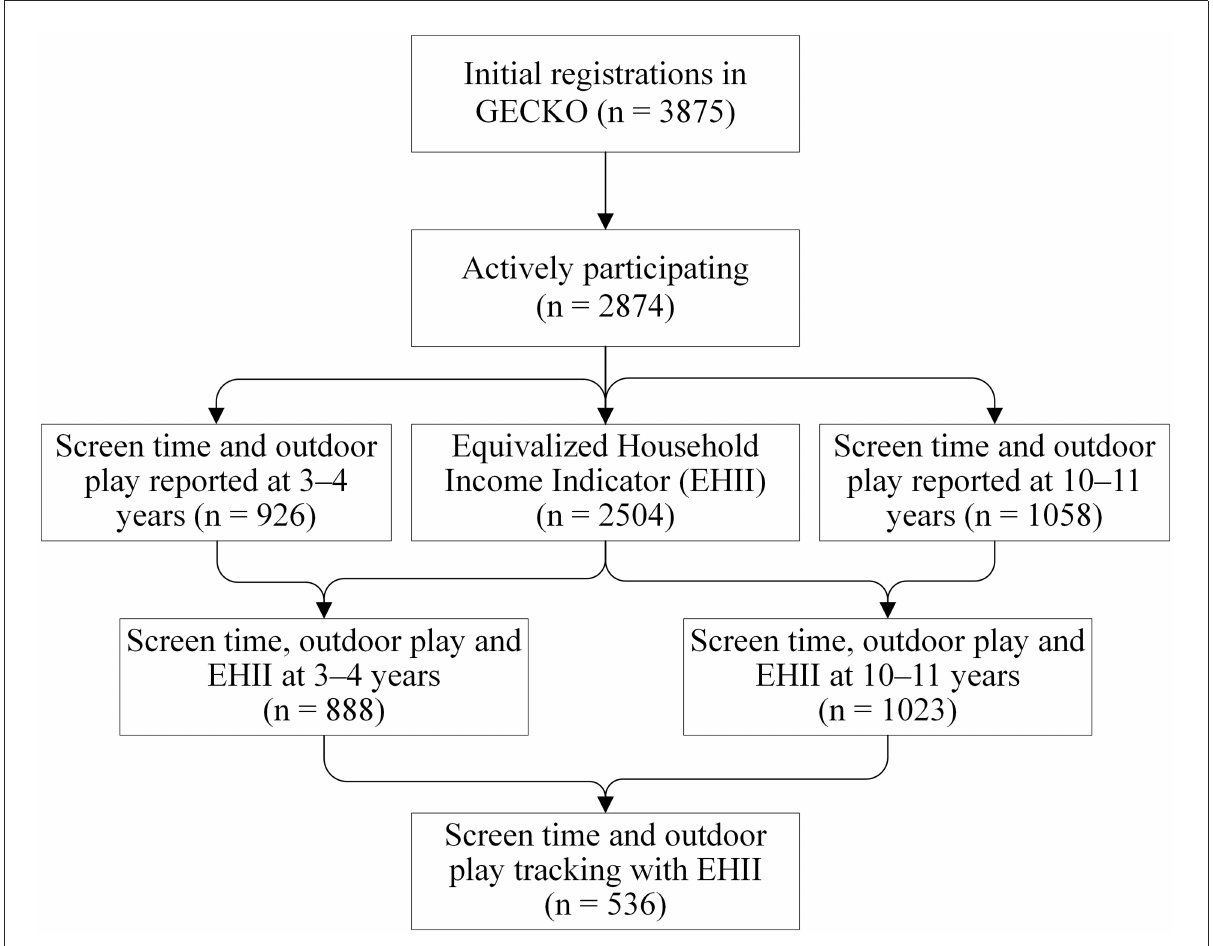
FIGURE1 Flowchart of the participants in the GECKO Drenthe